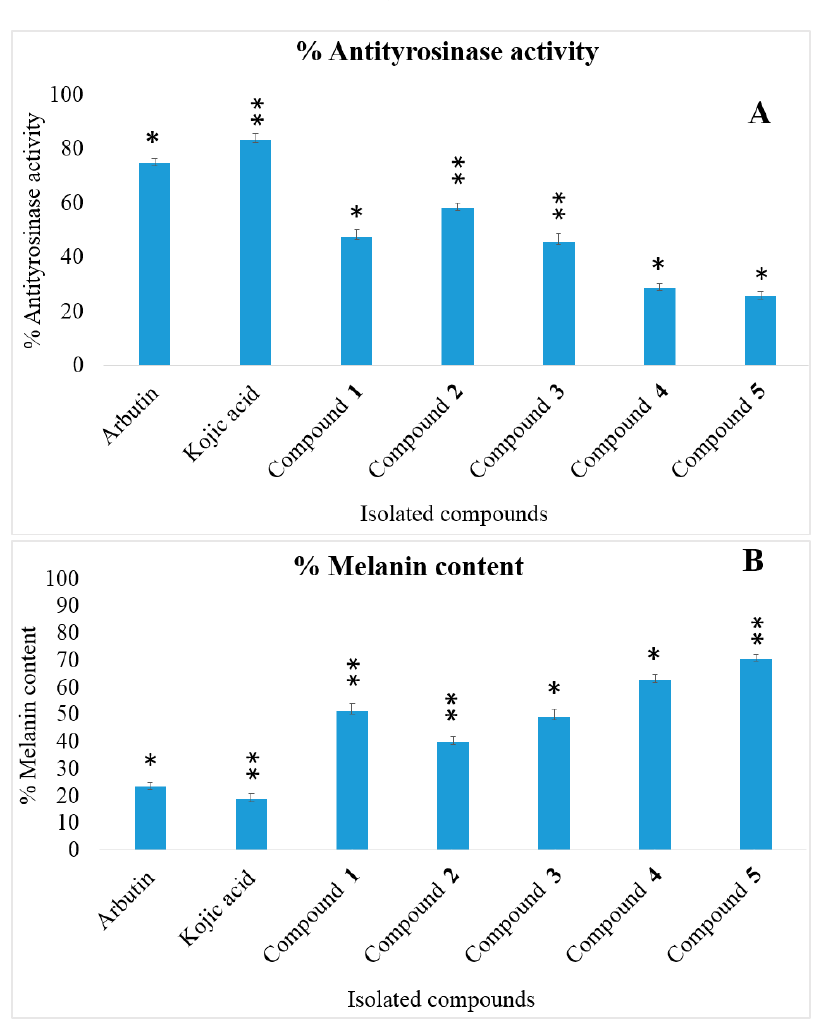
Figure 4. Intracellular antityrosinase activity ( A ) and melanin content ( B ) in B16-F1 cells. Data were expressed as mean ± SD from three independent experiments. * p < 0.05 and ** p < 0.01 indicated a significant difference from the positive control group. Compound 1 = ω -hydroxymoracin C; Compound 2 = moracin M; Compound 3 = moracin C; Compound 4 = 3, 4, 3 ′ , 5 ′ -tetrahydroxybibenzyl; Compound 5 = piceatannol; positive controls = arbutin and kojic acid.